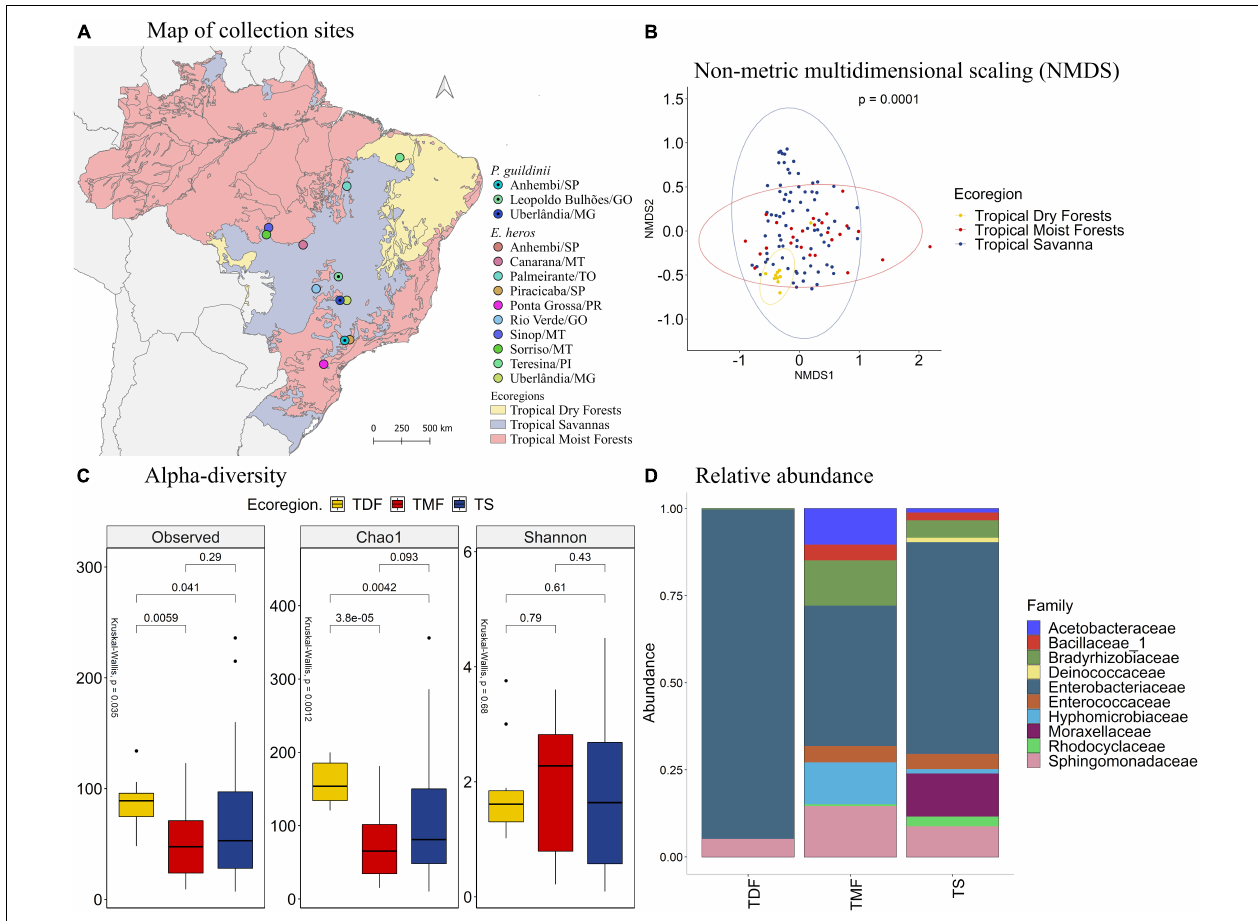
FIGURE 5 | (A) Mapping of collection sites of E. heros and P. guildinii , classified by ecoregion in Brazil. (B) NMDS of Bray-Curtis similarity matrix among 115 samples from the intestinal microbiome of E. heros and P. guildinii , for the different ecoregion from Brazil. The ellipses are showing clustering between ecoregion. Multivariate analysis of variance (PERMANOVA) is indicated in the upper right. (C) Alpha diversity levels based on Observed OTU, Chao1 index and Shannon index for the different ecoregion. The non-parametric test (Kruskal–Wallis) is indicated in the upper left of each graph. Pairwise comparison (Wilcoxon) is indicated between Ecoregions. (D) Analysis of the ten most abundant bacteria families in the intestinal microbiome of E. heros and P. guildinii collected in Brazil, classified by